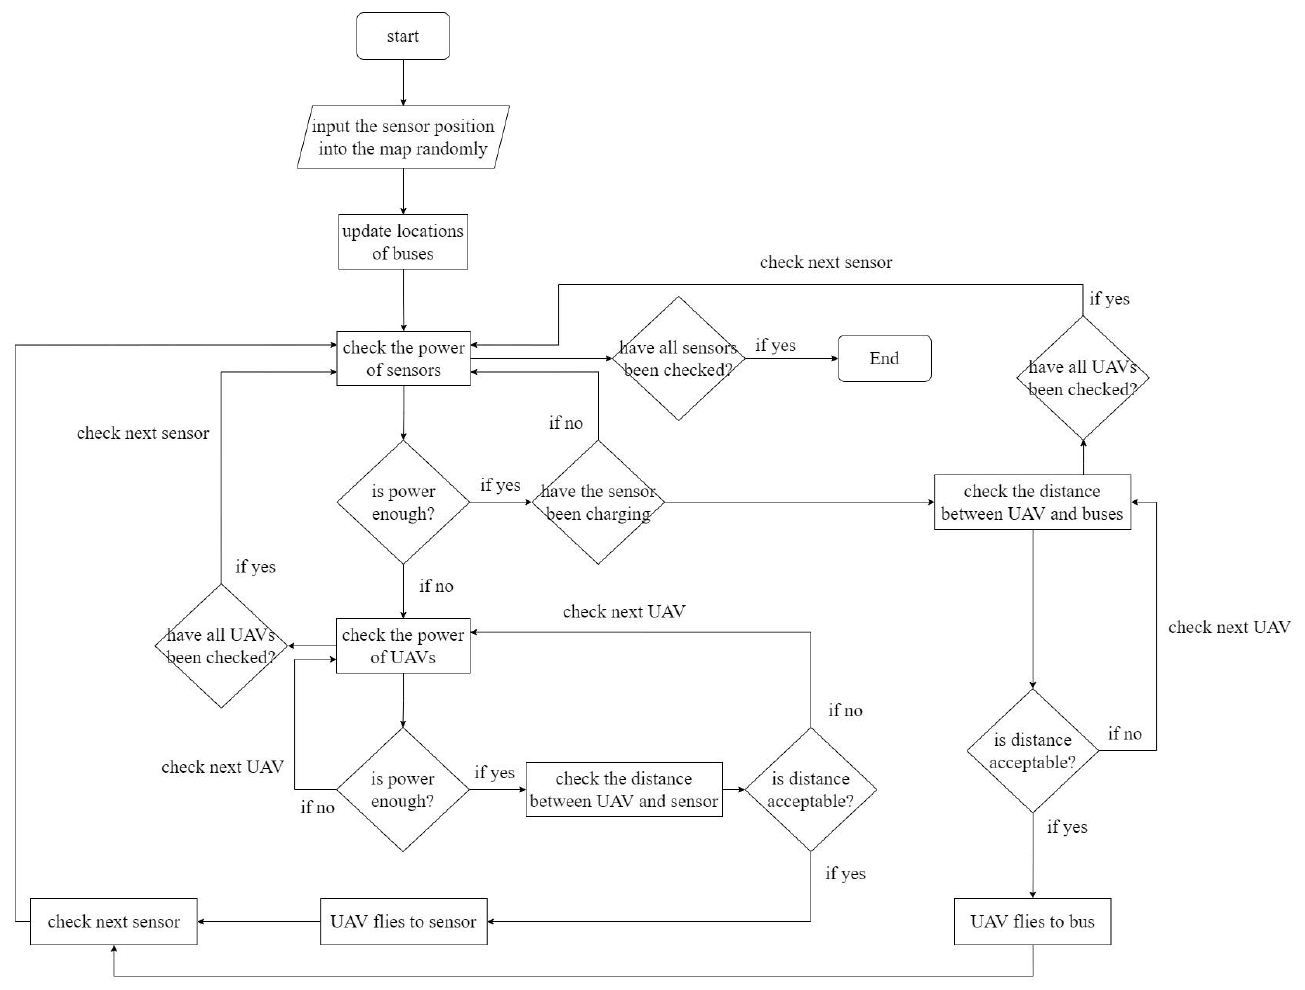
Figure 1. Flow chart of the charging process. Algorithm 1: Charging Strategy with Naïve Charging